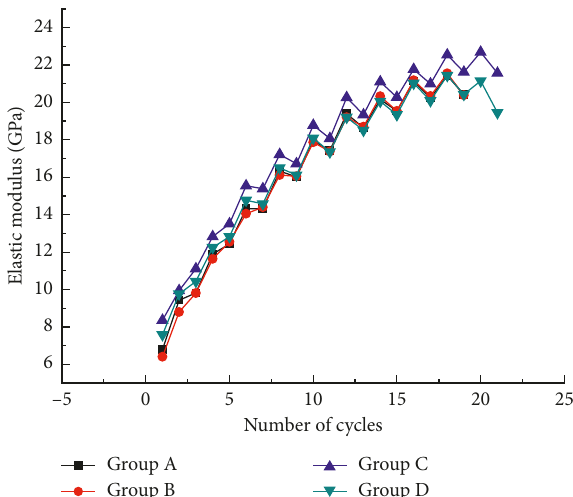
Figure 6: Curve of elasticity modulus of loading and unloading and